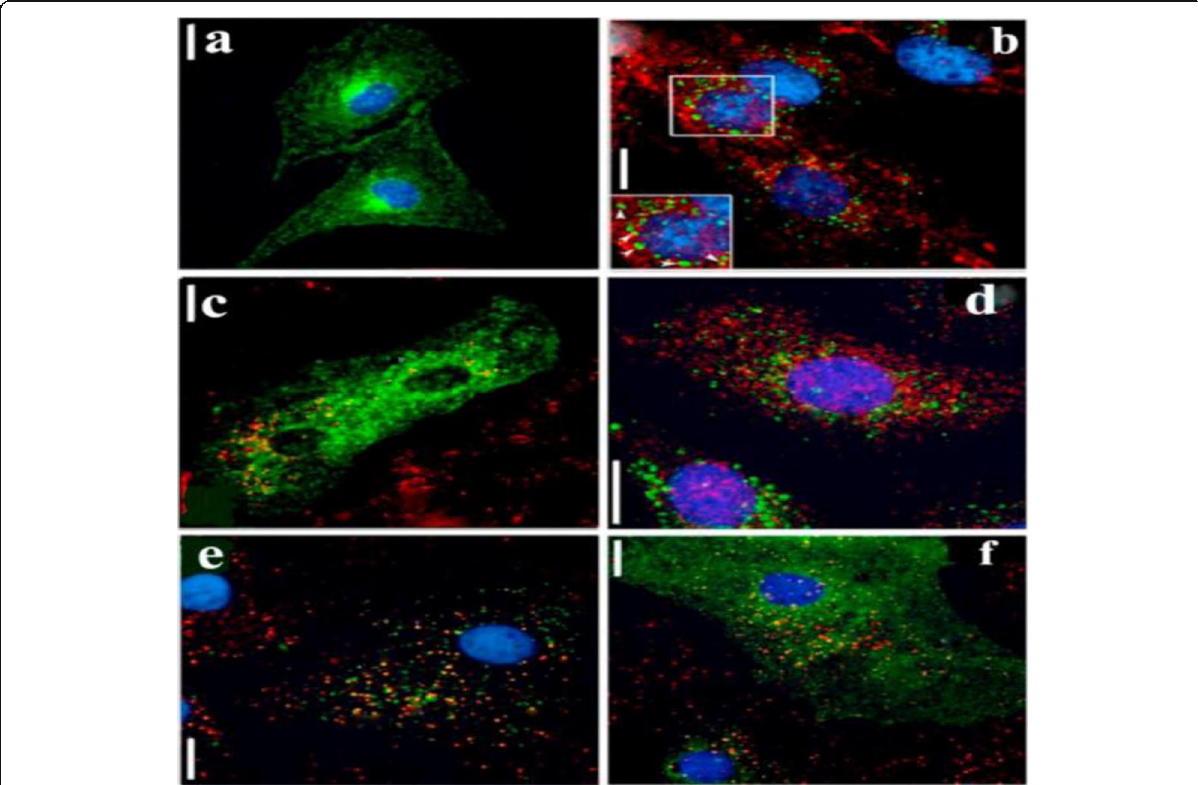
Fig. 10 Confocal microscopic images of pegylated CFTX-dendrimers after 1h incubation in the bacterial perinuclear segment a ; endosome b , localization of fractional CFTX dendrimers in lysosomes c , d ; endosomal localization of dendrimers 10 min of incubation e , f . [ “ Reprinted (adapted) with permission from [37]. Copyright 2019 Elsevier. ”